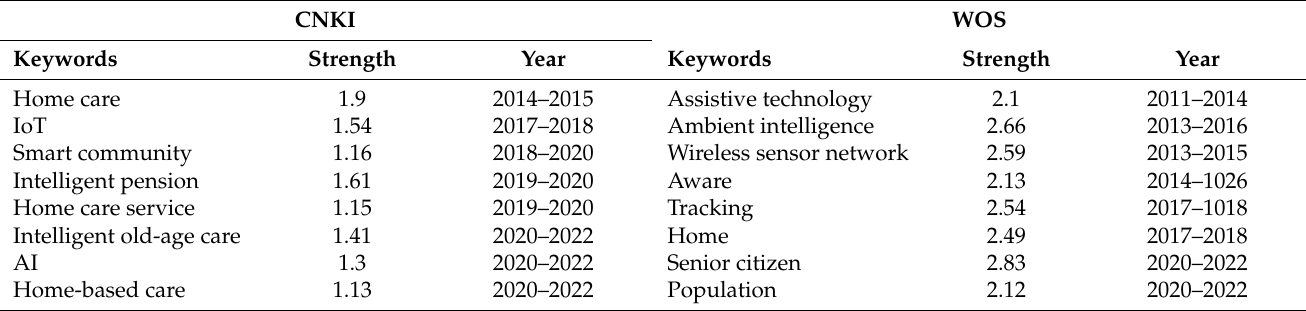
Table 9. Burst terms in studies from CNKI and